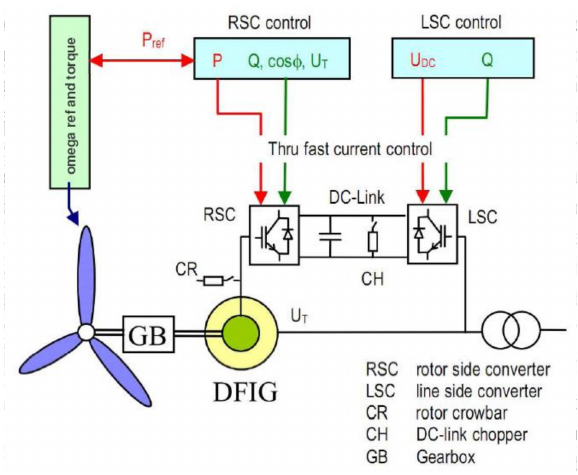
Figure 3. Model of the Doubly-Fed Induction Generator (DFIG) scheme [11].